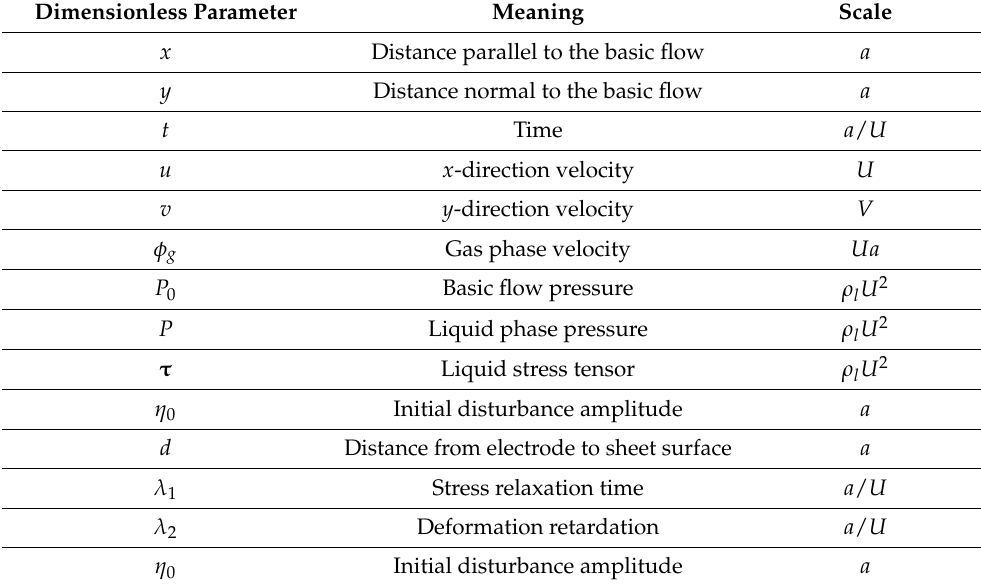
Table 1. Scales of dimensionless parameters.